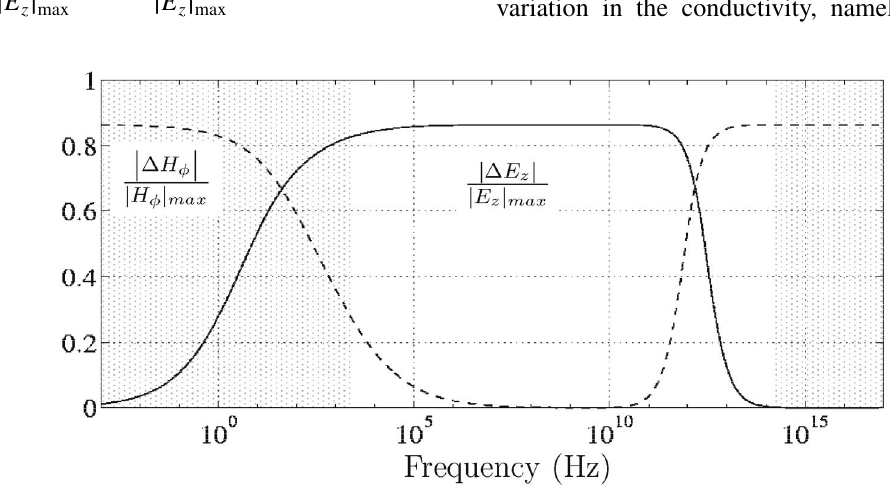
FIG. 4. Variation of the H and E on the surface of the conductor, normalized to their maximum values (on the boundary). The (cid:19) z frequency is in logarithmic scale. In the shaded regions, the approximate boundary conditions assumed are not strictly valid. ( b (cid:1) 2 cm , n (cid:1) 1 ).